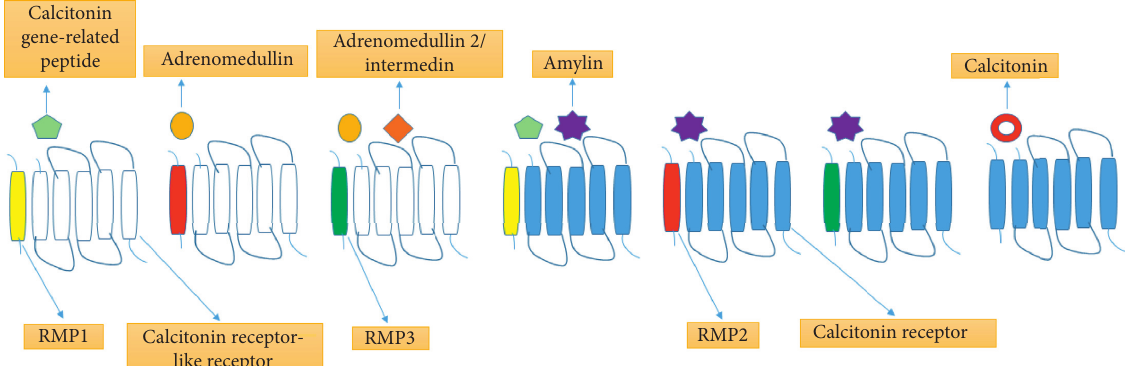
Figure 1: Classification and composition of human calcitonin family receptors showing various receptors (labeled below the figure) and ligands (labeled above the